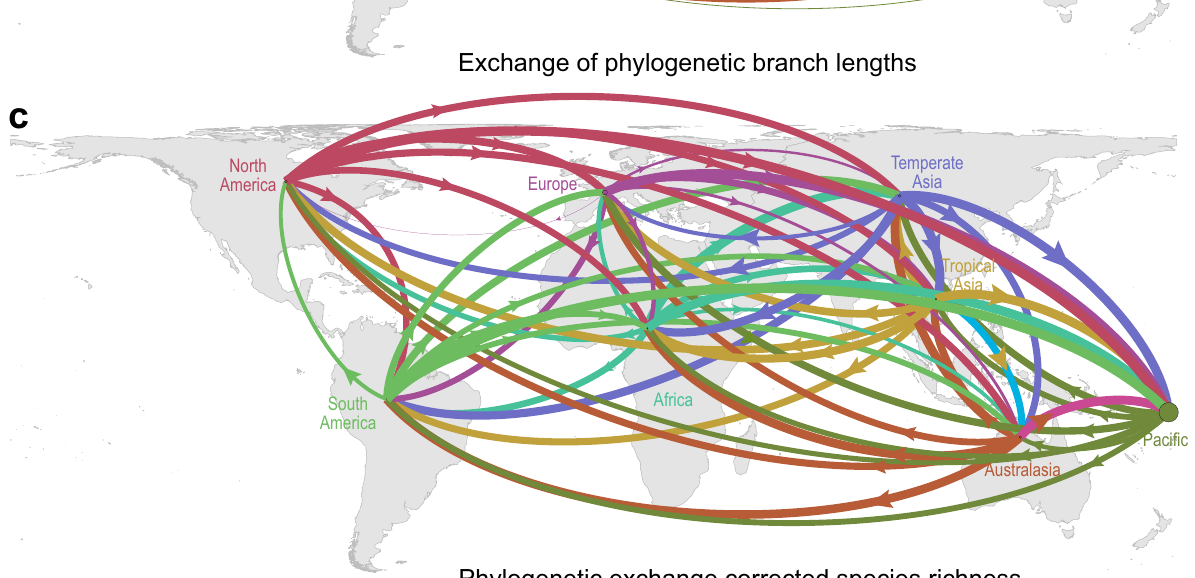
cross-validation design. The ensemble predictions from species distribution models were derived using un-weighted ensemble means. Predictive model performance was assessed using a 5-fold spatial block cross-validation. We generated a total of 230,000 range maps, representing species within 382 families at a resolution of 50× 50 km which was also resampled to 100 ×100 km. To our knowledge, this makes it the largest and only global assessment of geographic distributions for plants at the species-level. Our approach of modeling species distributions follows